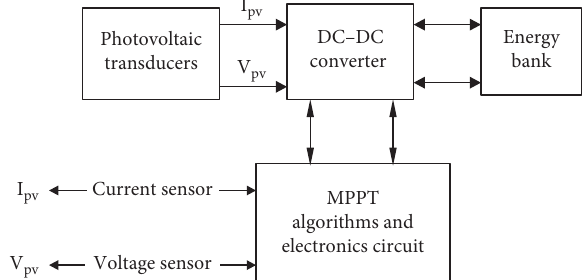
Figure 31: Basic energy harvesting system with a conventional MPPT